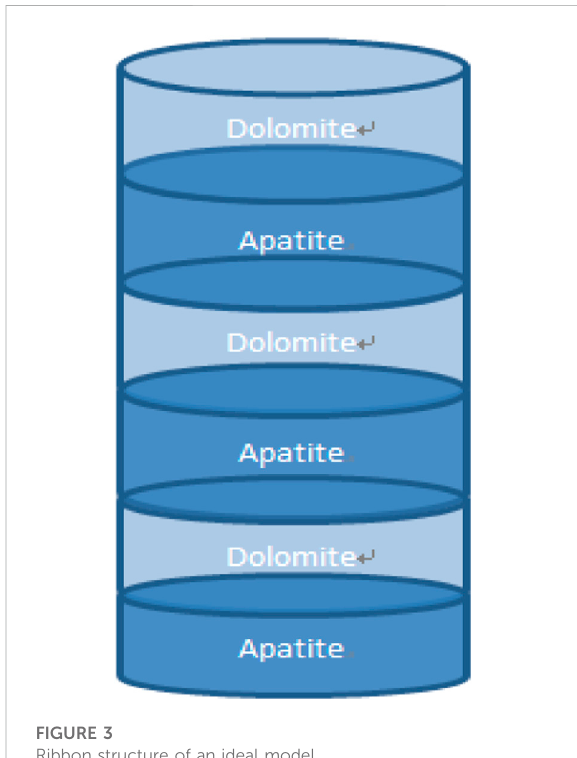
FIGURE 3 Ribbon structure of an ideal